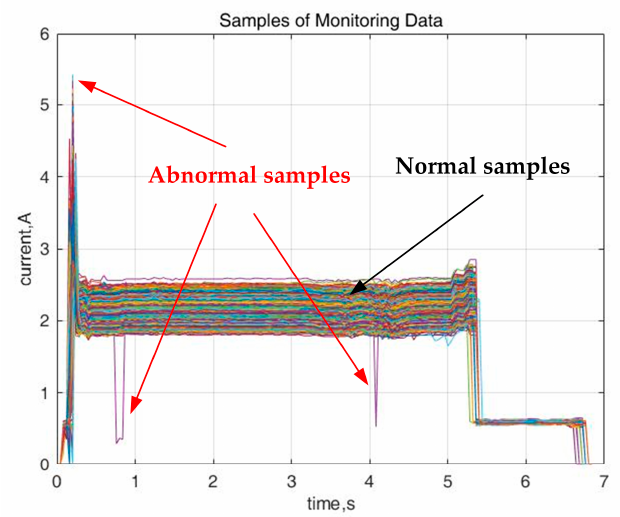
Figure 4. The cumulative current samples from a certain station.